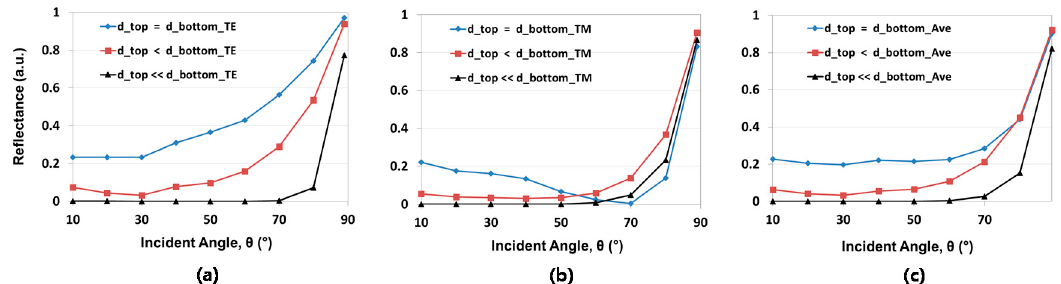
Figure 8. Calculated surface reflection at 600 nm wavelength with various incident angles, 10 ◦ ~89 ◦ , and 45 ◦ fixed azimuth angle of light in ( a ) transverse electric (TE) mode, ( b ) transverse magnetic (TM) mode, and ( c ) averaged reflectance of TE and TM modes.